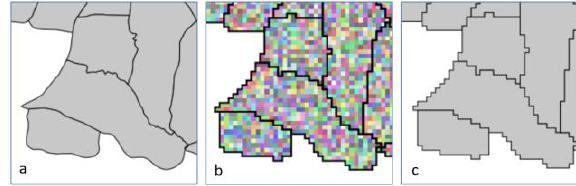
Figure 4 . Spatial units a) input, b) raster grid overlaid with final gridded vector, c) final gridded vector (data adapted from GRASS GIS sample data North Carolina,